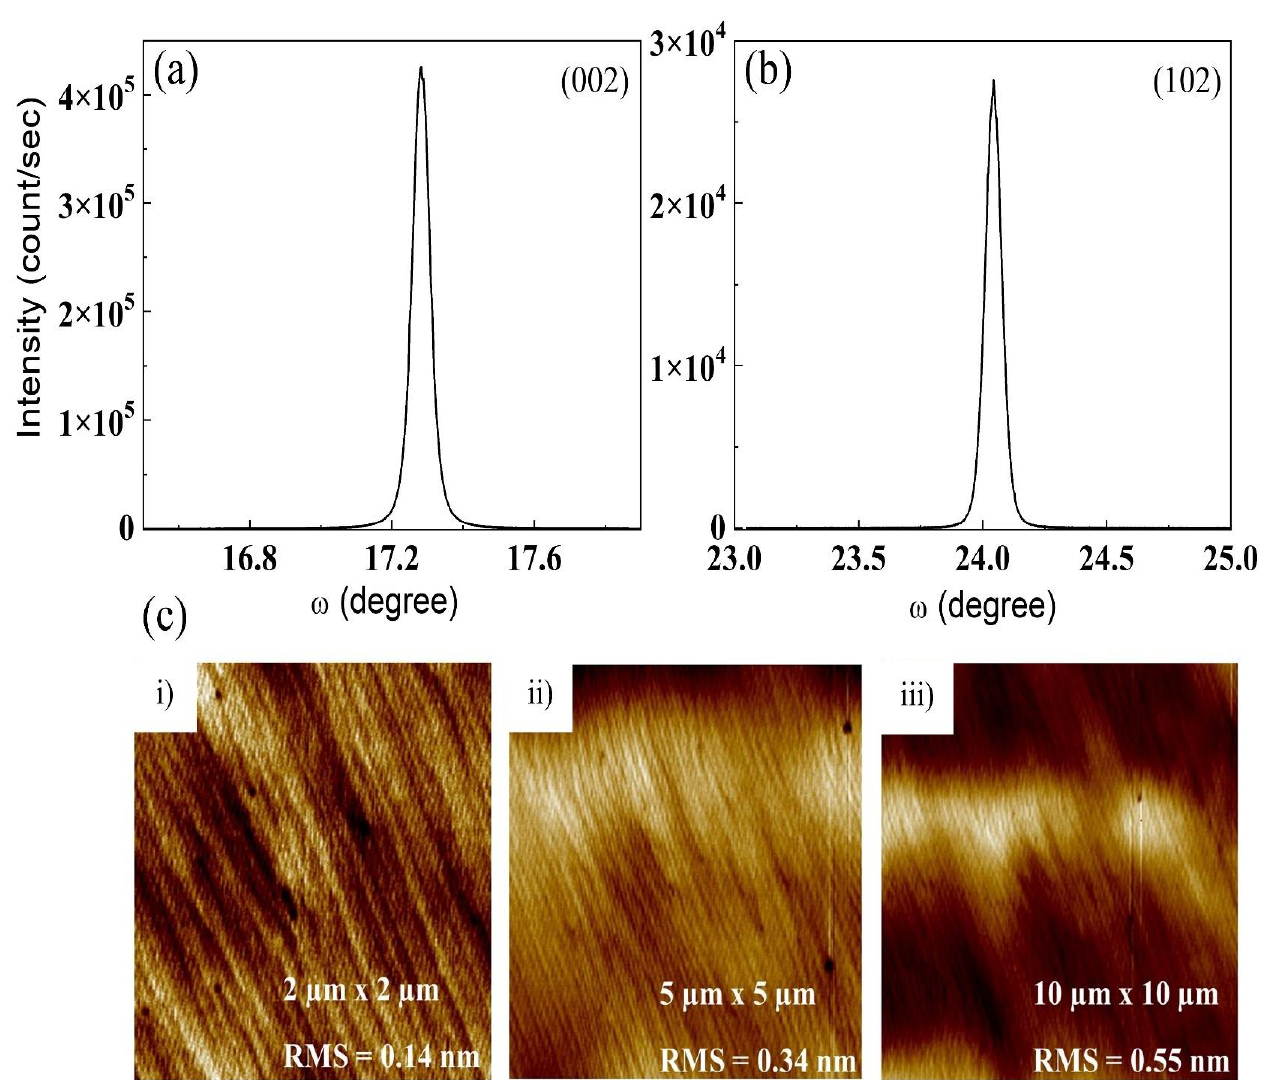
Figure 1. ( a ) XRD ω -scan for two-step grown GaN layer in (002), ( b ) (102) directions and ( c ) 2D AFM images for the surface of two-step grown GaN layer at different magnifications.